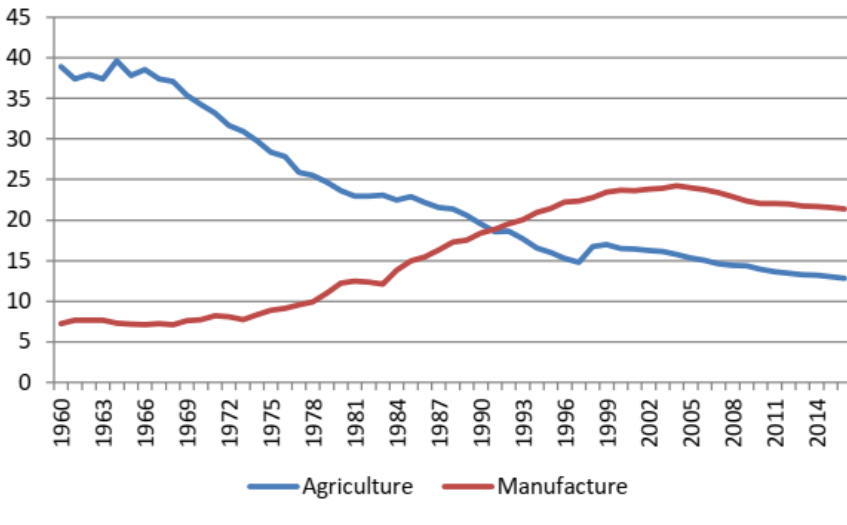
Figure 1: Contributions of Manufacturing and Agriculture to Gross Domestic Product 1960-